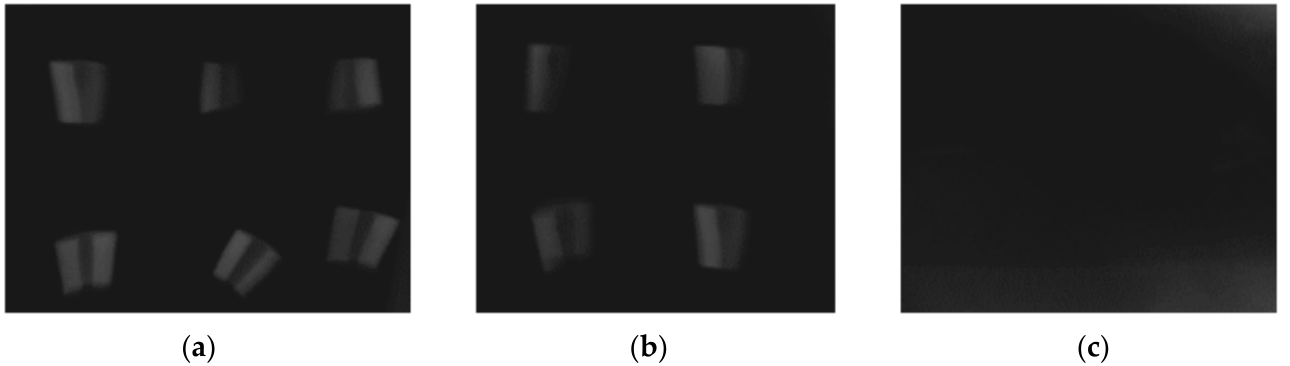
Figure 3. ( a ) Dental radiographic image of the dentin samples prior to EDTA conditioning. ( b ) Dentin after 12 h surface decalcification exhibits no visible change in image contrast. ( c ) After 4 weeks of decalcification, the dentin grafts are no longer discernible in the images.